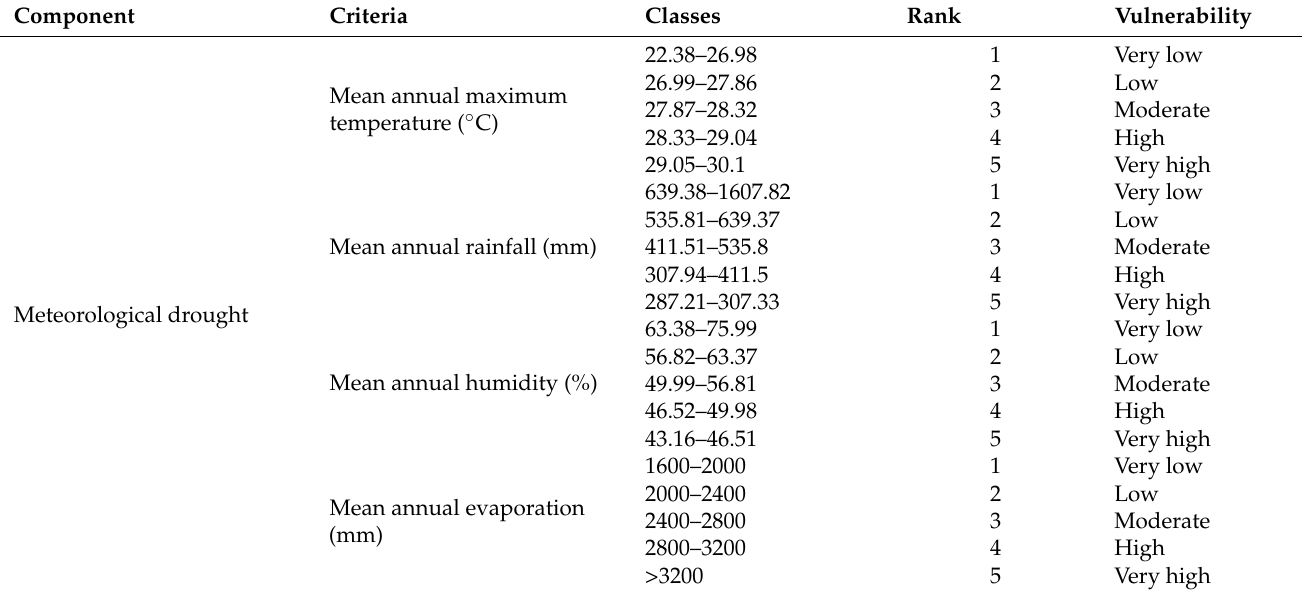
Table 2. Alternative ranking of each criterion following the influence to drought vulnerability. Component Criteria Classes Rank